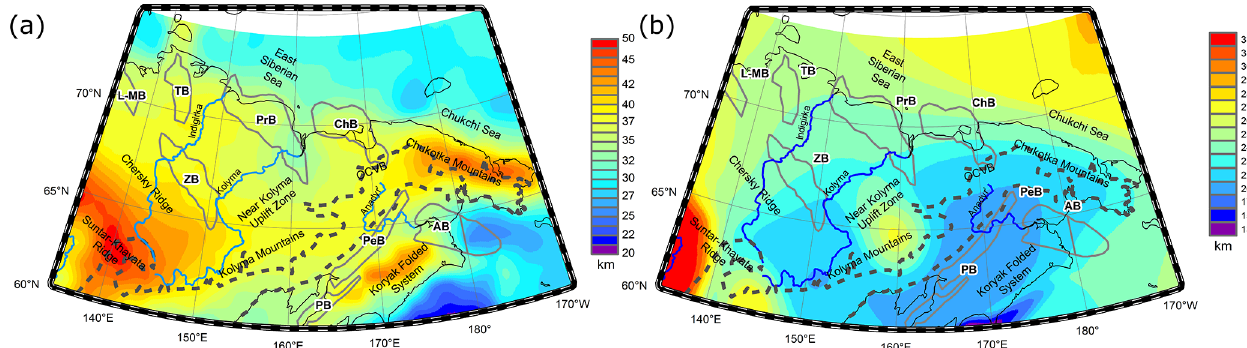
Figure 4. (a) Depth to the Moho from the sea level. (b) EET of the lithosphere.